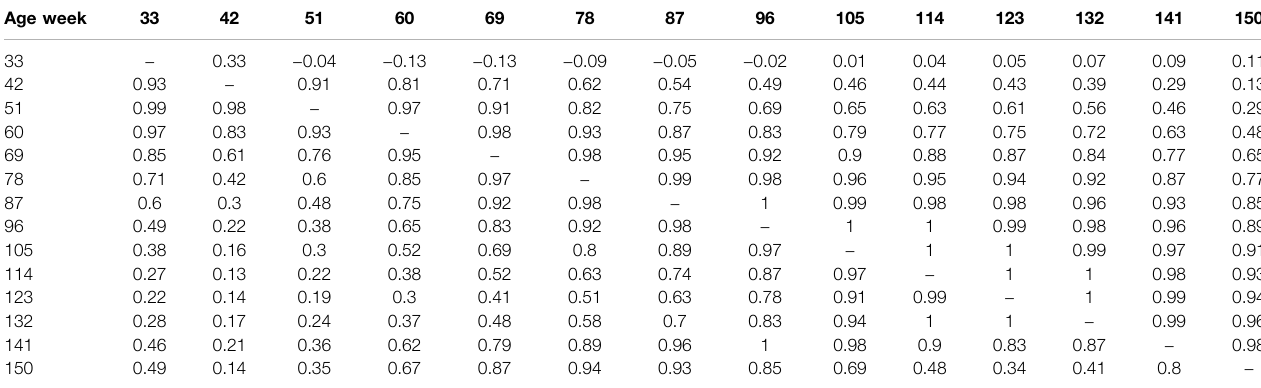
TABLE 7 | Genetic correlations between abnormal sperm percentage of all ages, estimated with a random regression model.